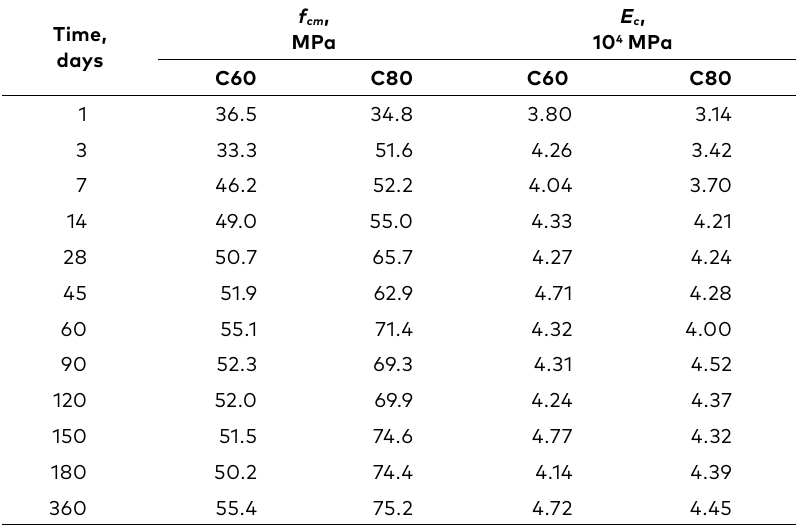
Table 2. Mechanical properties of